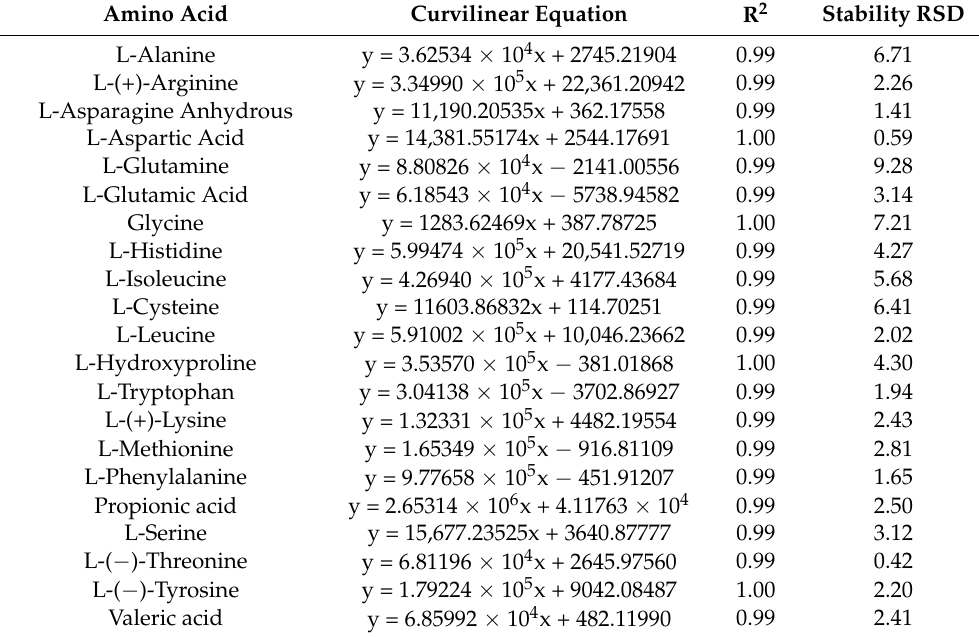
Table 1. Standard curve equation of 21 types of amino